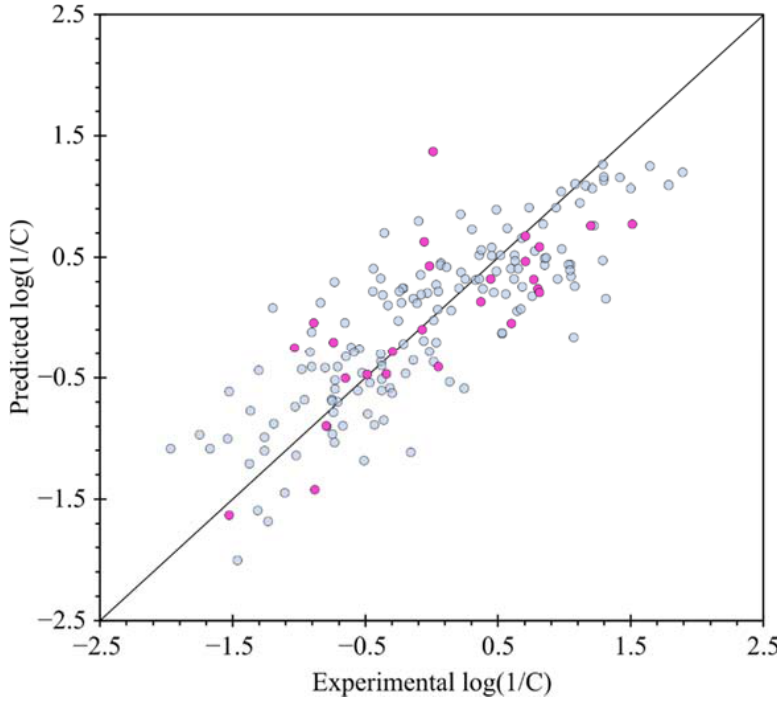
Figure 4. Graph of predicted values of log(1/C) vs. experimental values of log(1/C) for training set (light blue dots) and for test set (violet dots); solid line is a diagonal plot. Table 3. Correlation matrix between variables of the model.